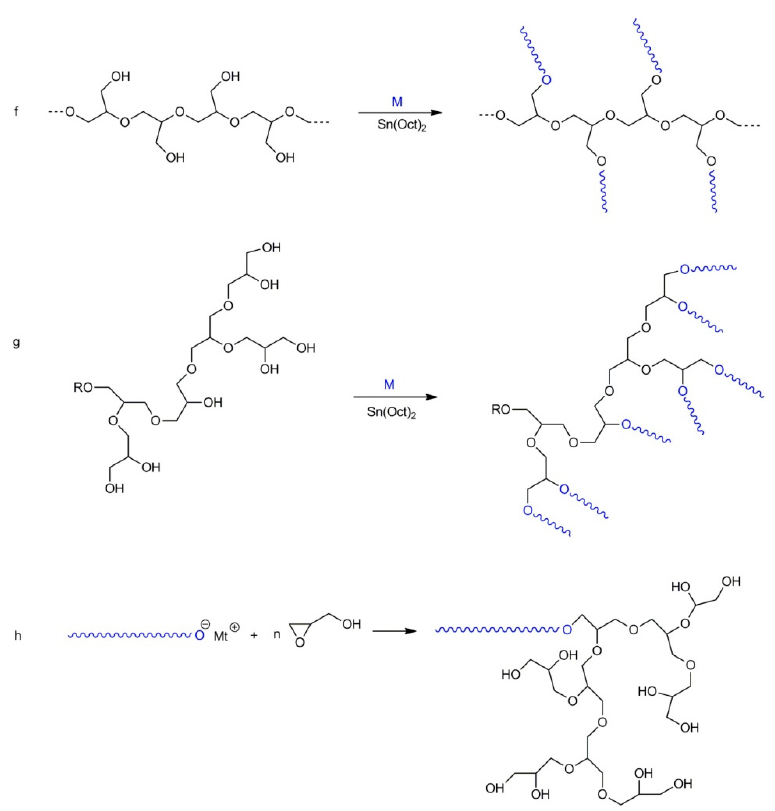
Scheme 18. Selected routes leading to copolymers with blocked polyglycidol